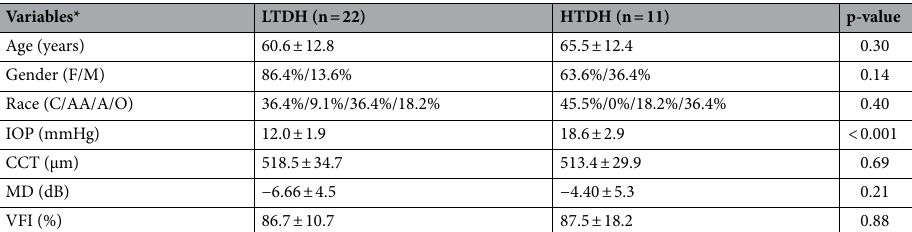
Table 1. Demographic and ocular characteristics of study participants. LTDH, low-tension optic disc hemorrhages; HTDH, high-tension optic disc hemorrhages; F, female; M, male; C, Caucasian; AA, African American; A, Asian; O, others; IOP, intraocular pressure; CCT, central corneal thickness; MD, visual field mean deviation; VFI, visual field index. *Data are given as mean ± standard deviation or